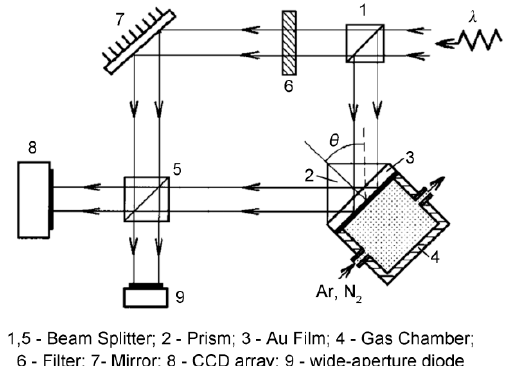
Figure 5. Spatial phase modulation interferometry scheme for SPR phase interrogation (Adapted from [49]).